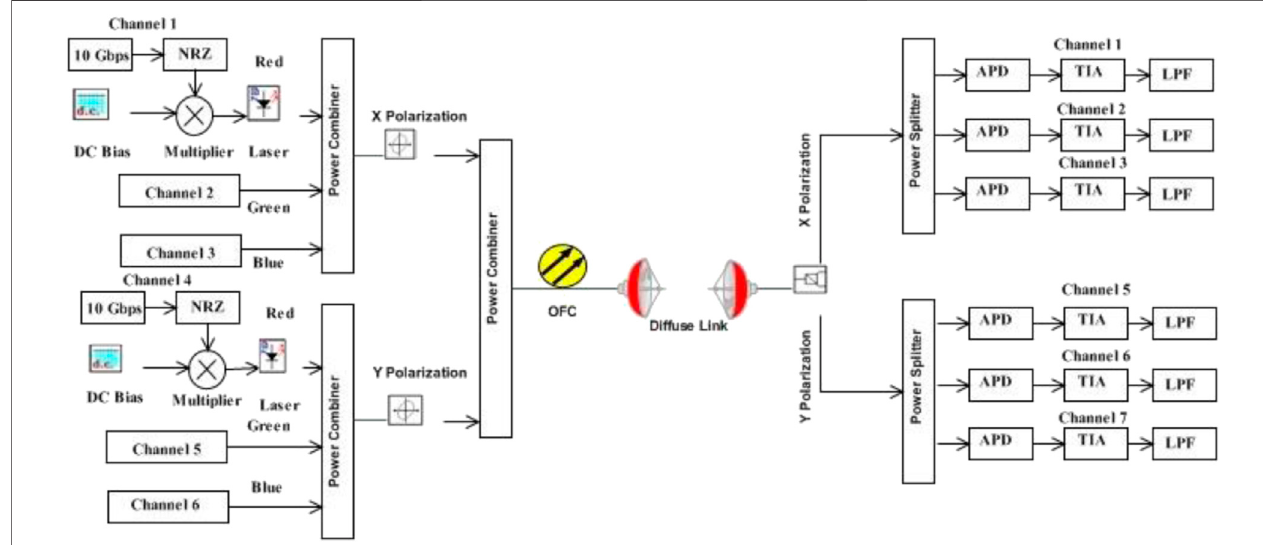
FIGURE 1 | Transmission of six channels over a VLC link using hybrid WDM and PDM schemes.